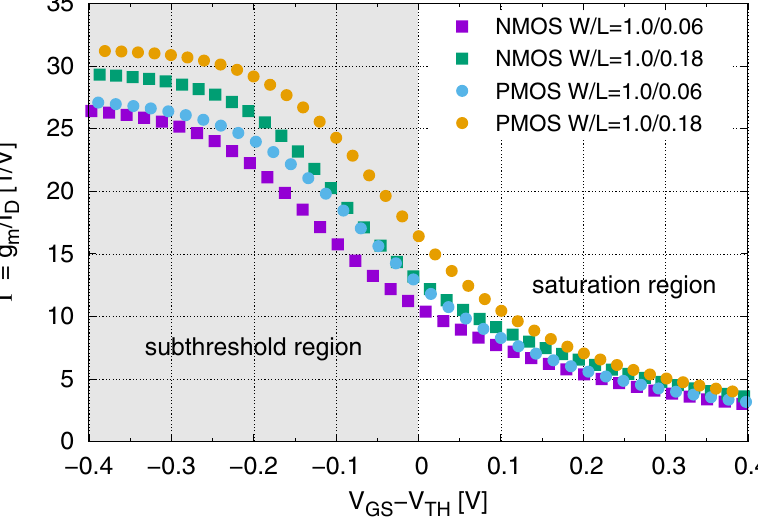
Figure 7. Plot of the g m -over- I D ratio versus V GS – V TH for two standard-threshold complementary devices of a 65-nm CMOS process. The plots for two different channel lengths are shown. The darker area identifies the subthreshold region. The lighter one, identifies the saturation region.